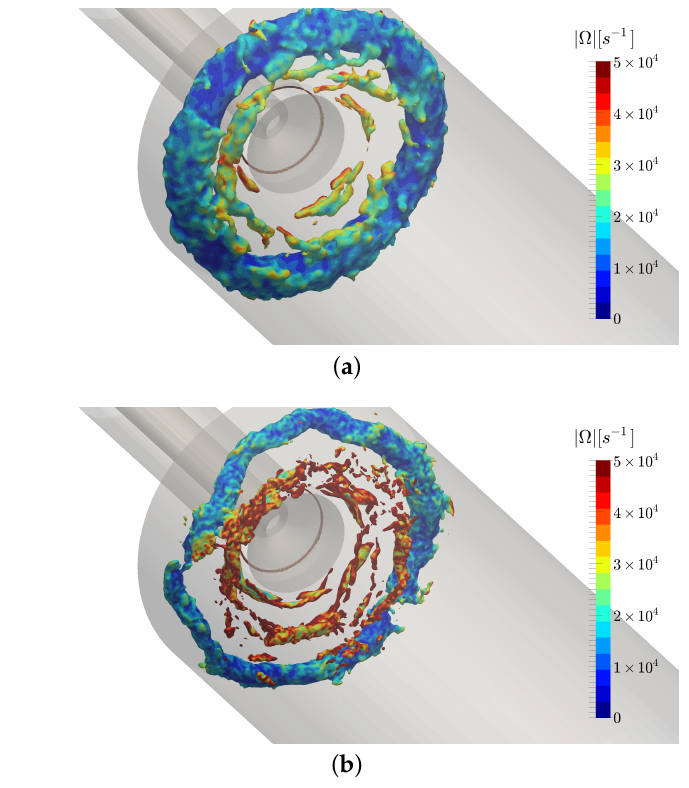
Figure 5. Annular flow structures’ visualization through instantaneous pressure coefficient isosurfaces ( C p = − 0.1), colored by vorticity magnitude | Ω | : ( a ) coarse grid; ( b ) fine grid.